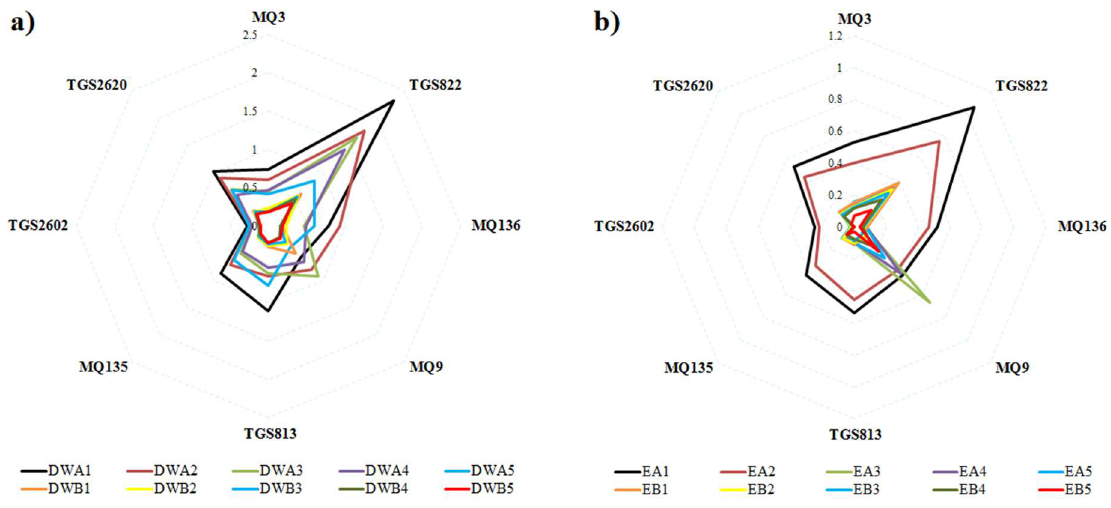
Figure 2. Radar graph sensor array responses to VOCs from DWEs and EO hydro-distillation extracts. Radar plots are displayed for: ( a ) Water extract of DWE (second distillate fraction), and ( b ) Oil extract of EO (first distillate fraction). Sensor response lines are color-coded by sample drying method (A & B) and plant age (1–5) combinations, for both DWE and EO samples types, as follows: black (A1), orange (B1), maroon (A2), yellow (B2), light green (A3), light blue (B3), purple (A4), dark green (B4), cyan (A5), and red (B5).